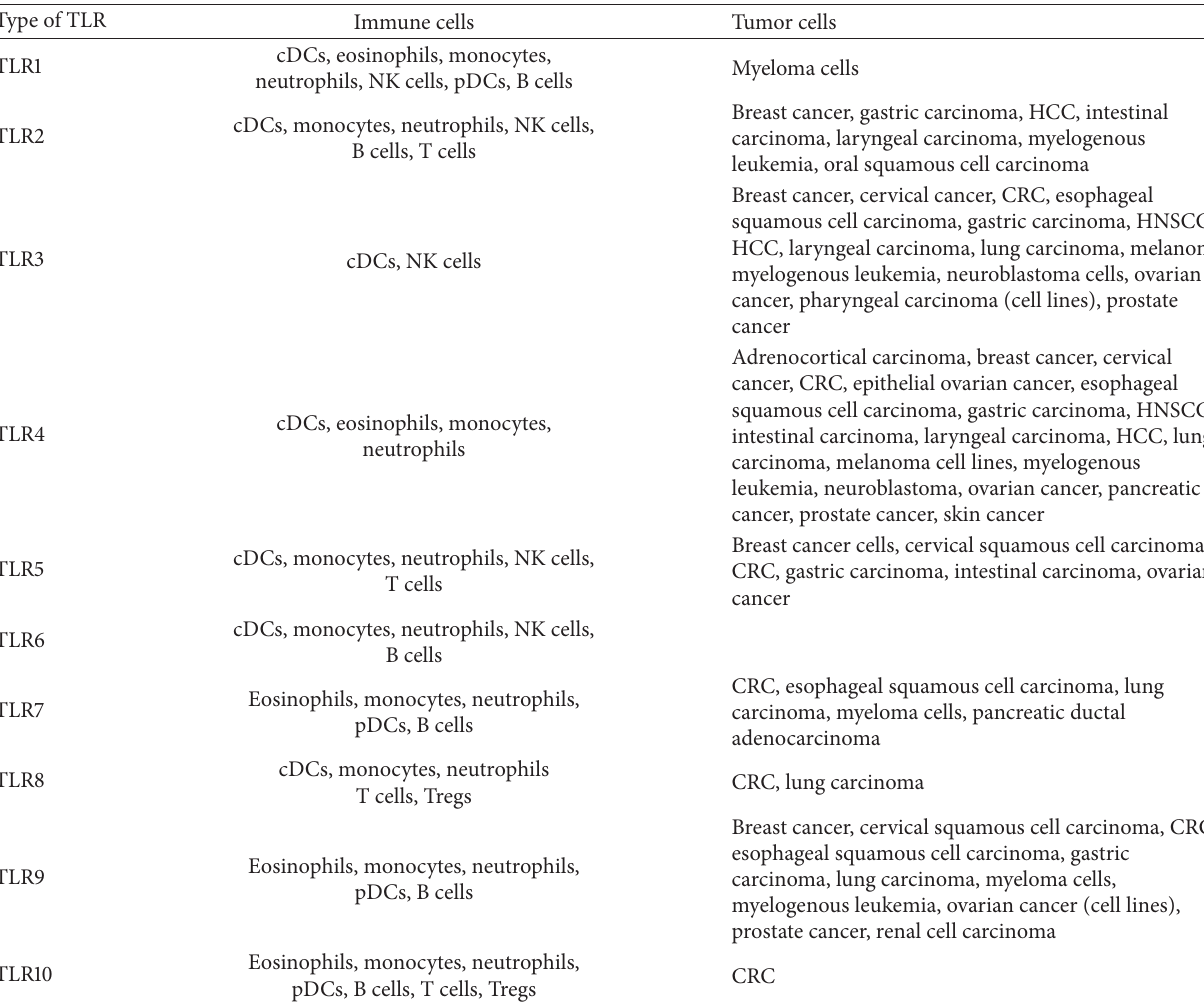
Table 4: TLR expression